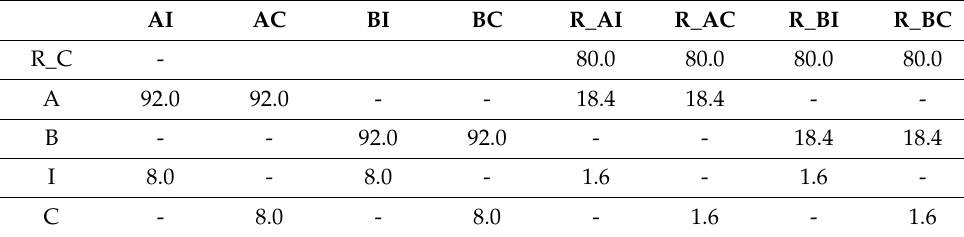
Table 2. Composition of raw mixtures,